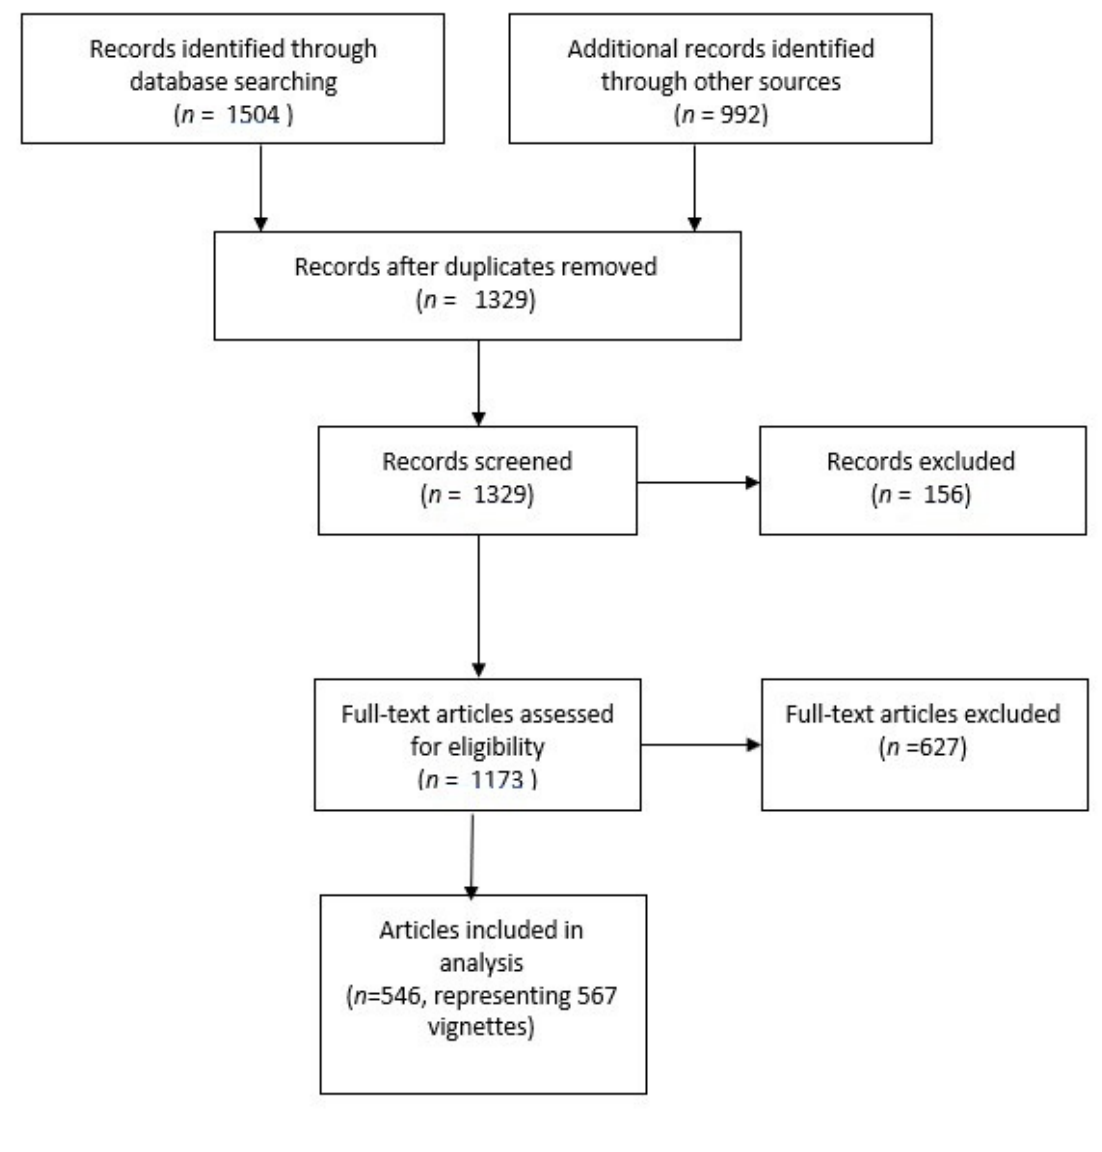
Figure 1. Flow diagram of literature searches [41].